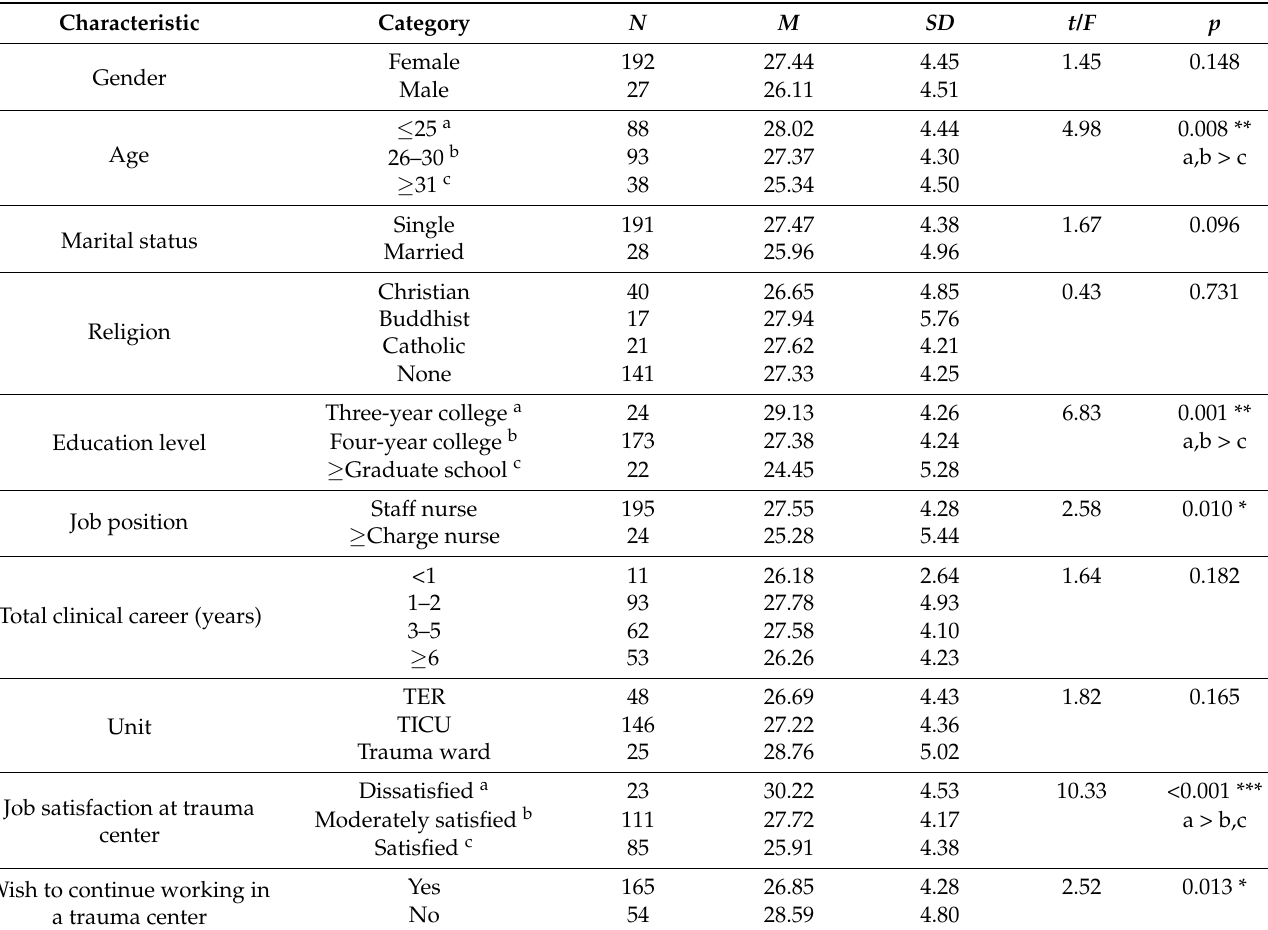
Table 4. Degree of burnout according to general characteristics and work-related characteristics (N = 219).